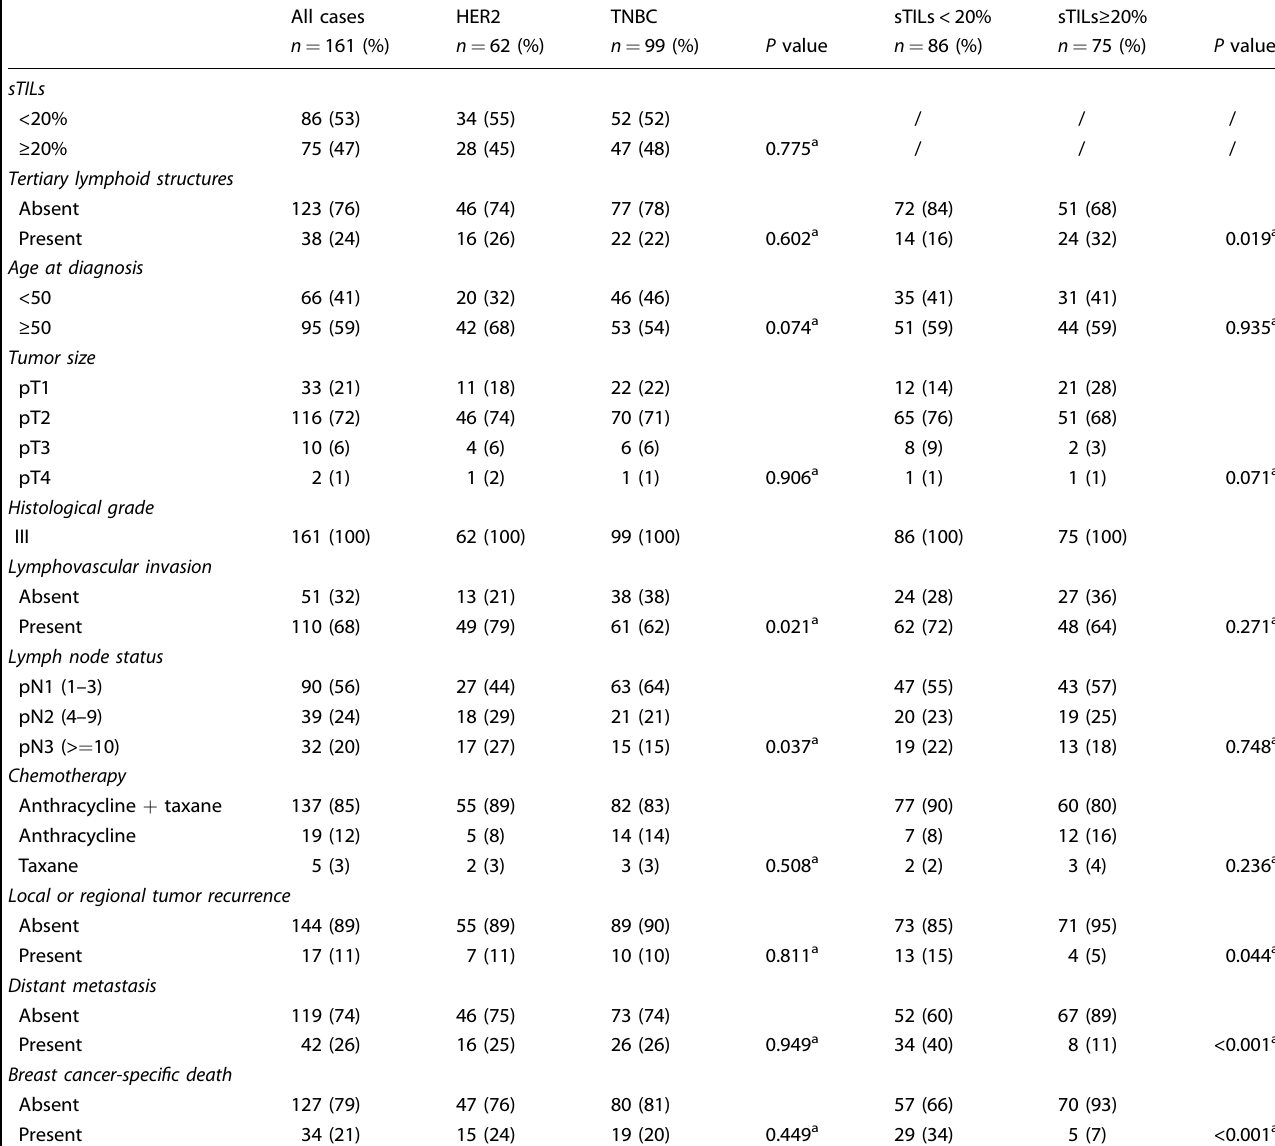
Table 1. Clinicopathological features and immune features of the primary tumor. All